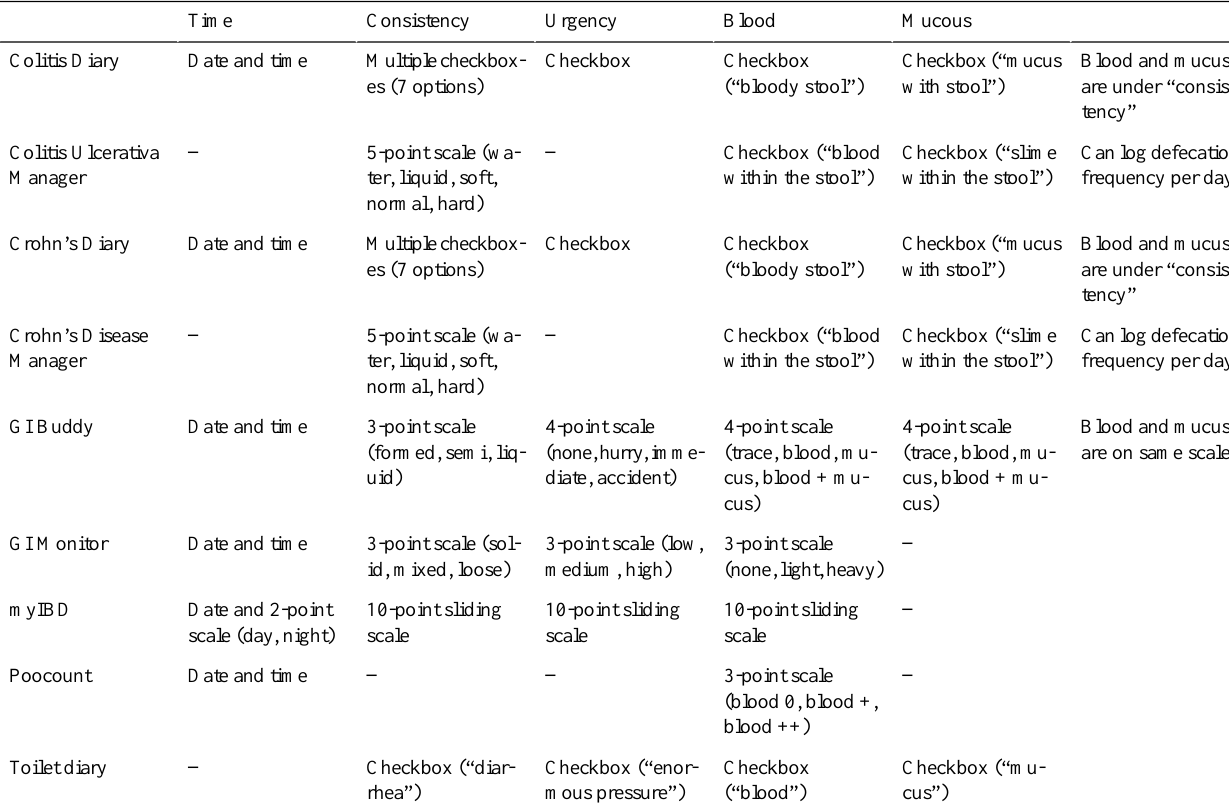
Table 5. Apps offering bowel motion